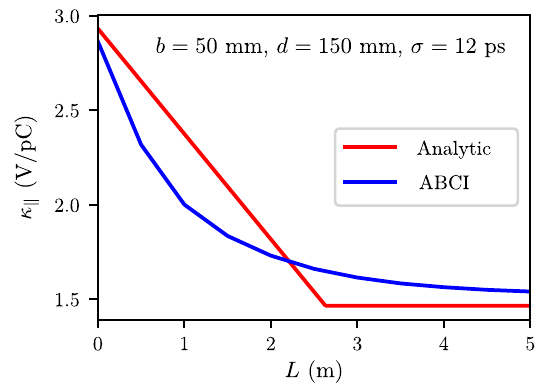
FIG. 8. The normalized impedance spectra of taper-in and taper-out from simulations for b ¼ 50 mm, d ¼ 150 mm, and L ¼ 3 m. The black line is the envelope of the normalized single- bunch power spectrum for σ ¼ 12